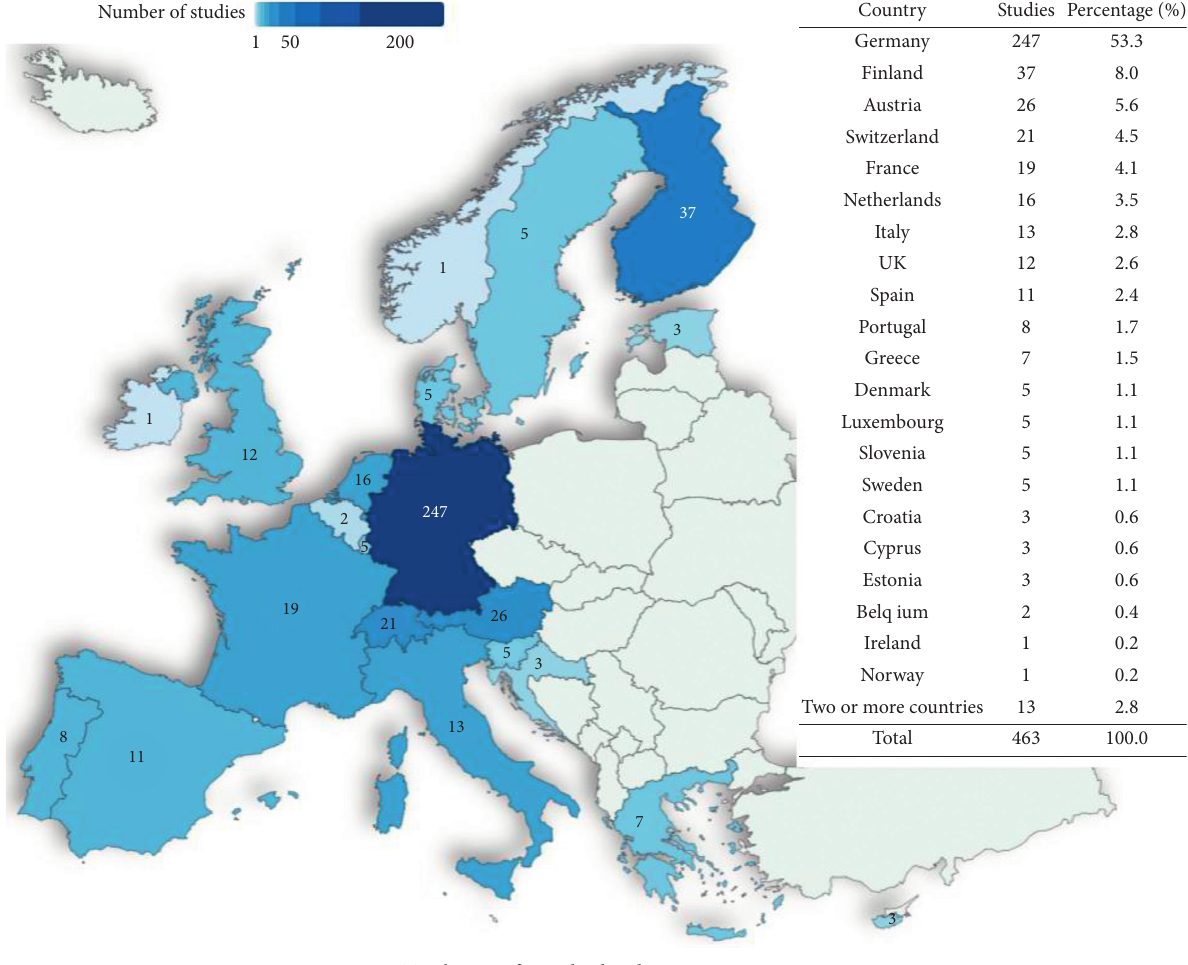
Figure 3: Total uses of standardized questionnaires in